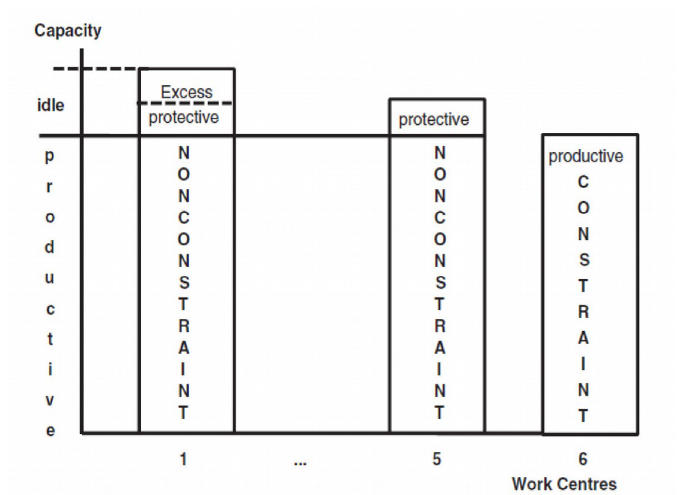
Figure 6. Productive and idle (protective and excess) capacities (Kim et al.,